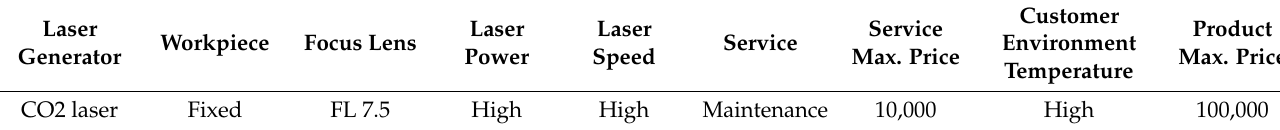
Table 10. Examples of customer’s